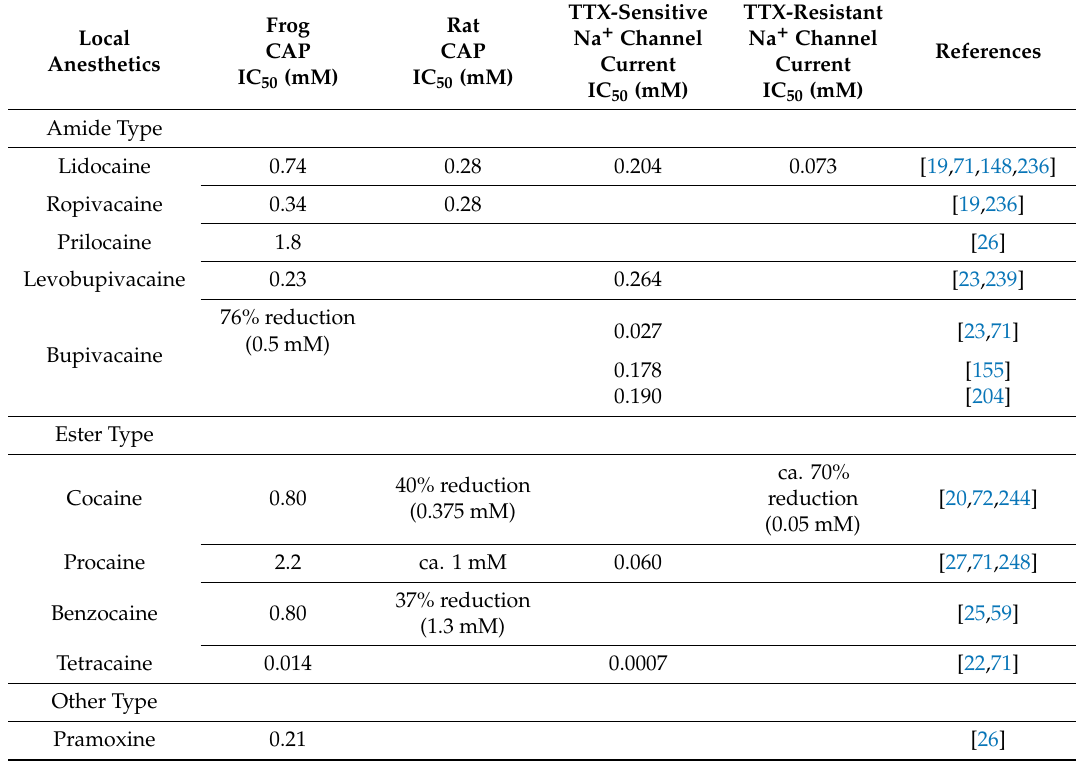
Table 6. Comparison of IC 50 values in inhibiting frog or rat sciatic nerve fast-conducting CAPs and TTX-sensitive or -resistant Na + channels among local